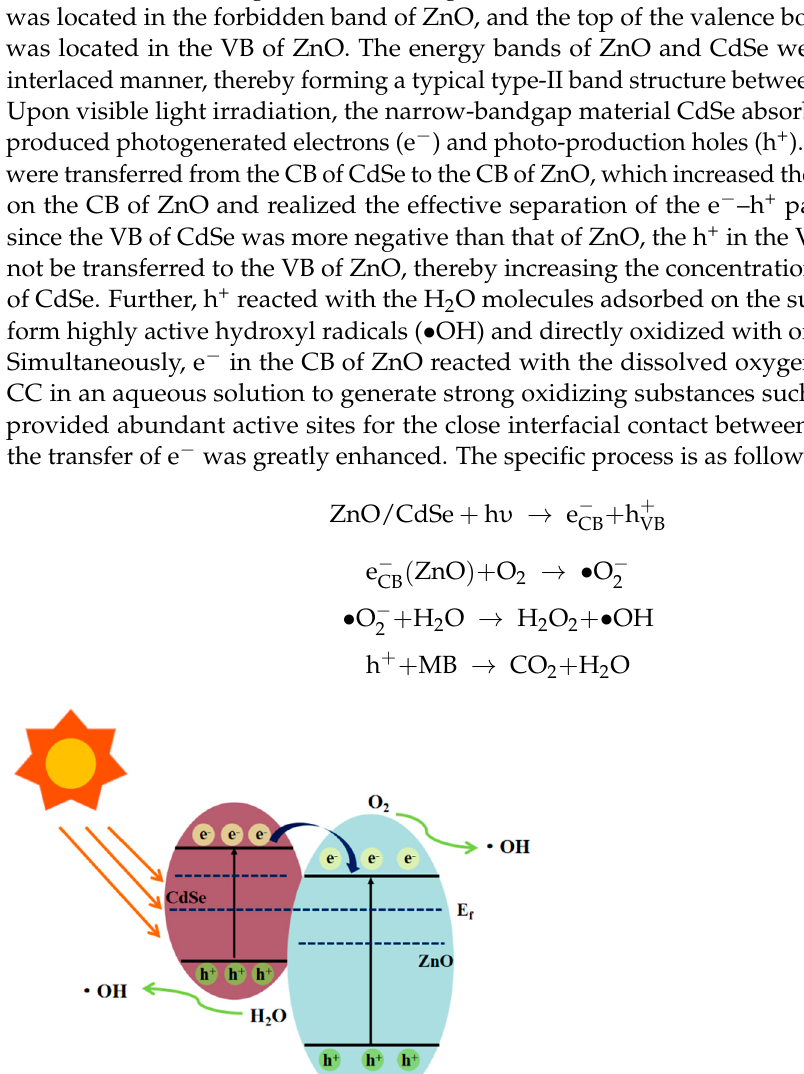
Table 2. Photocatalytic degradation parameters of different samples.